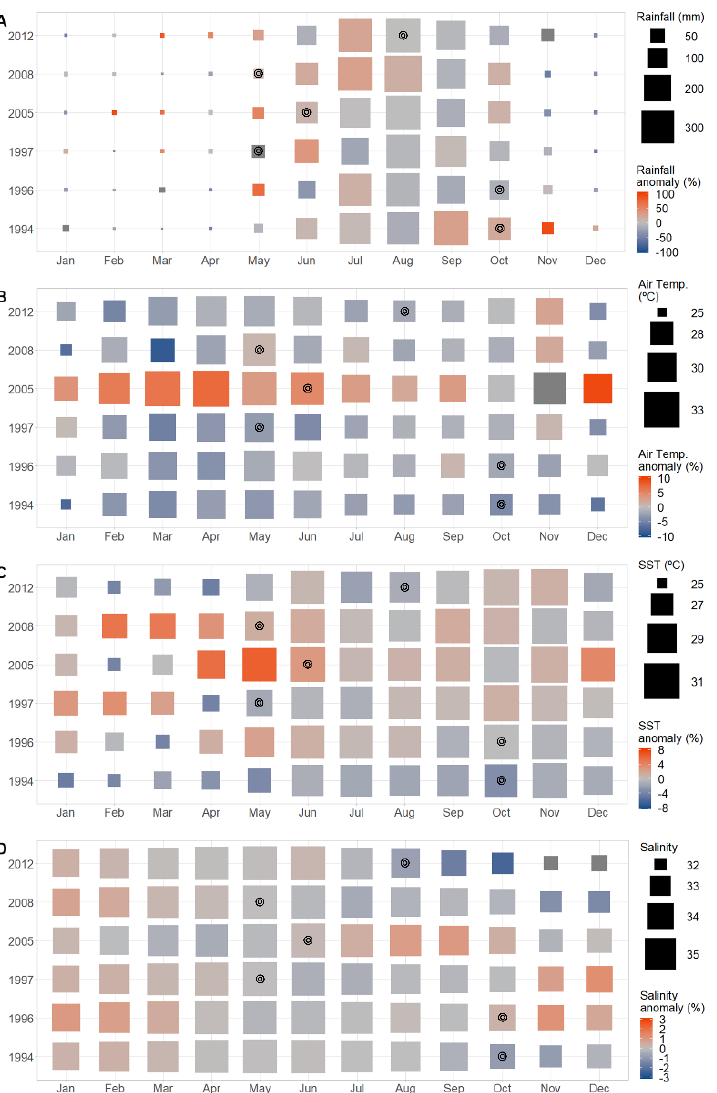
Figure 4. Temporal variation of the environmental parameters for the major cholera epidemic years between 1986 and 2013 in Guinea-Bissau. ( A ) rainfall; ( B ) air temperature; ( C ) SST; ( D ) salinity. Heat map shows the deviation of each parameter from the 27-year average. Circles indicate the month of cholera onset for each epidemic.